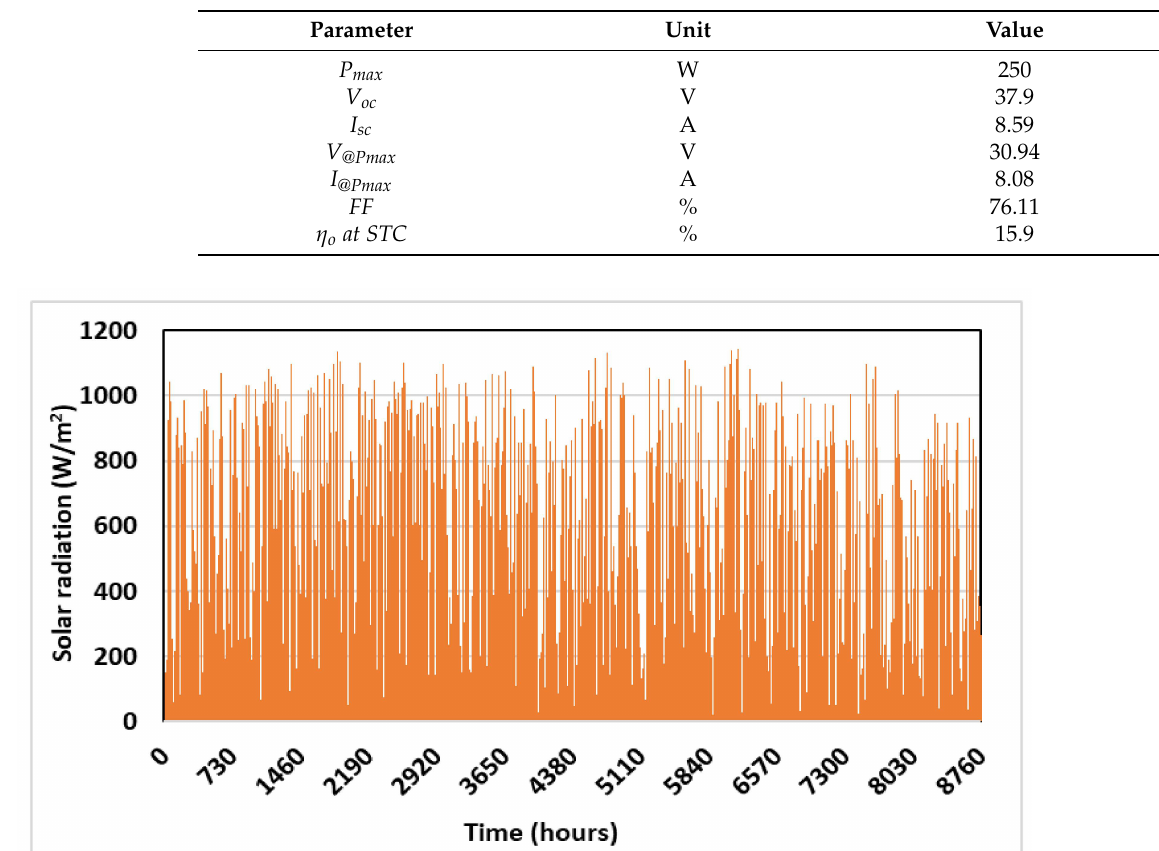
Table 2. Specification of conventional photovoltaic panel.